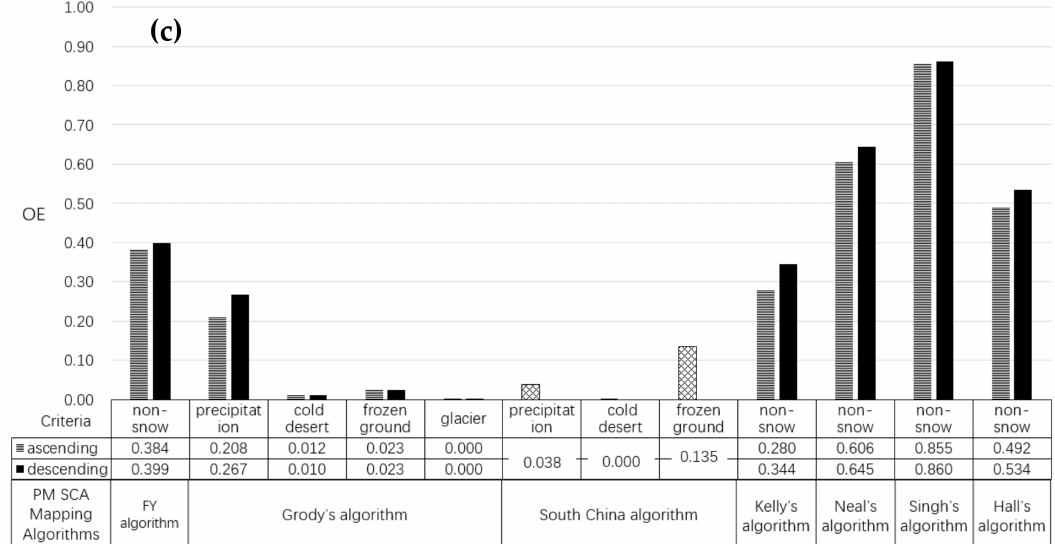
Figure 9. The evaluation results of classification criteria for each algorithm: PPV ( a ), CE ( b ), OE ( c